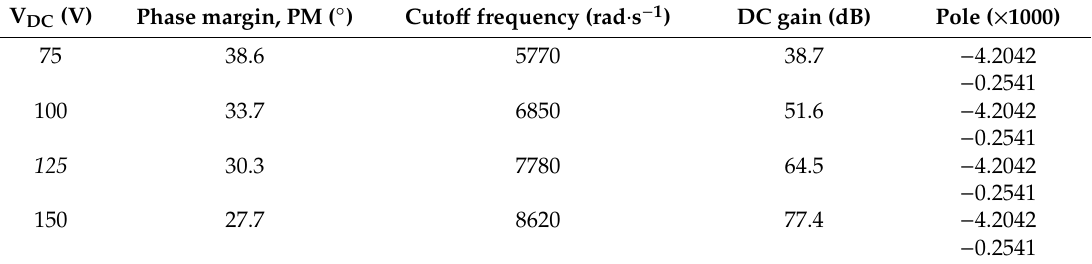
Table 4. Summary of the harmonic response according to the DC bus